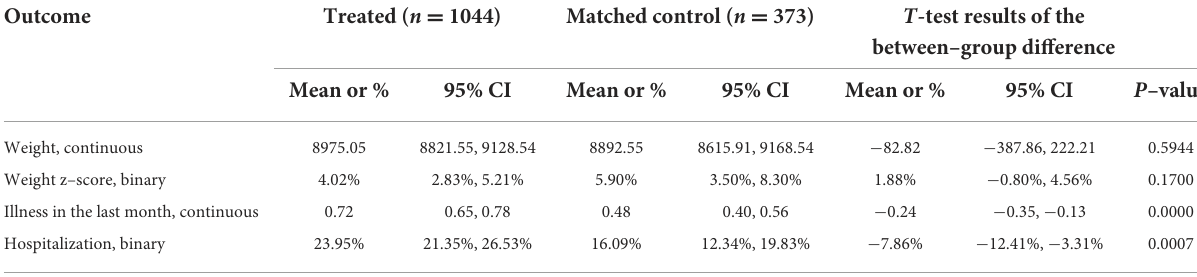
TABLE 2 Neonatal outcomes between the treated and matched control groups after propensity score matching in the contemporaneous group. Outcome Treated ( n = 1044) Matched control ( n = 373) T -test results of the